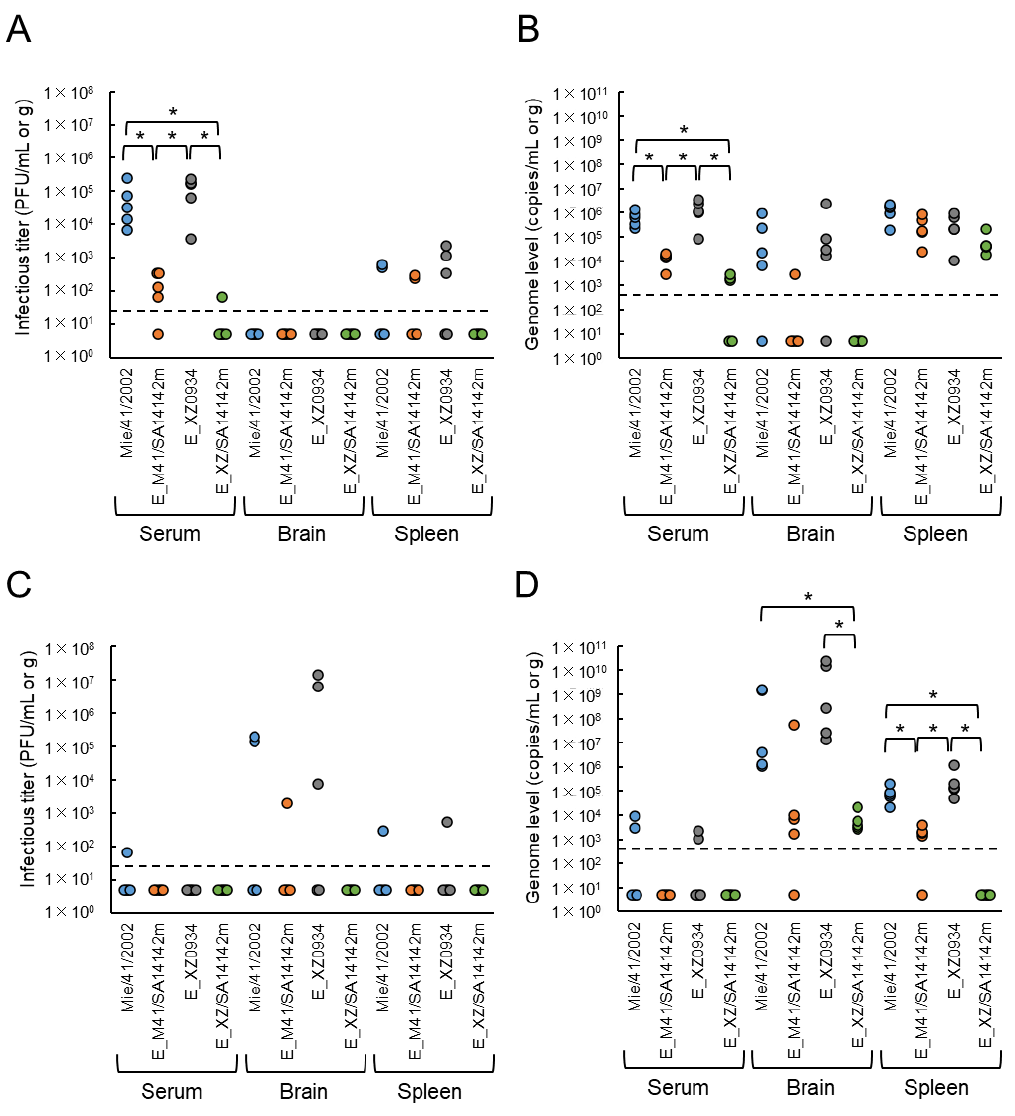
Figure 5. Levels of infectious virus ( A , C ) and viral RNA ( B , D ) at two ( A , B ) and five ( C , D ) days after inoculation of JEV-infected mice. Mice inoculated i.p. with 1 × 10 4 PFU of Mie/41/2002 ( n = 5), E M41/SA14142m (E_M41/SA14142m, n = 5), E XZ0934 (E_XZ0934, n = 5), or E XZ/SA14142m (E_XZ/SA14142m, n = 5) were euthanized at two or five days after inoculation, and serum, brain, and spleen samples were collected. Sera and tissue homogenates were used to quantify the infectious virus titer (PFU/mL or g) ( A , C ) and viral genome (genome copies/mL or g) ( B , D ). Dotted line: detection limit. Significance was analyzed using the Kruskal-Wallis test (* 0.01 < p < 0.05).